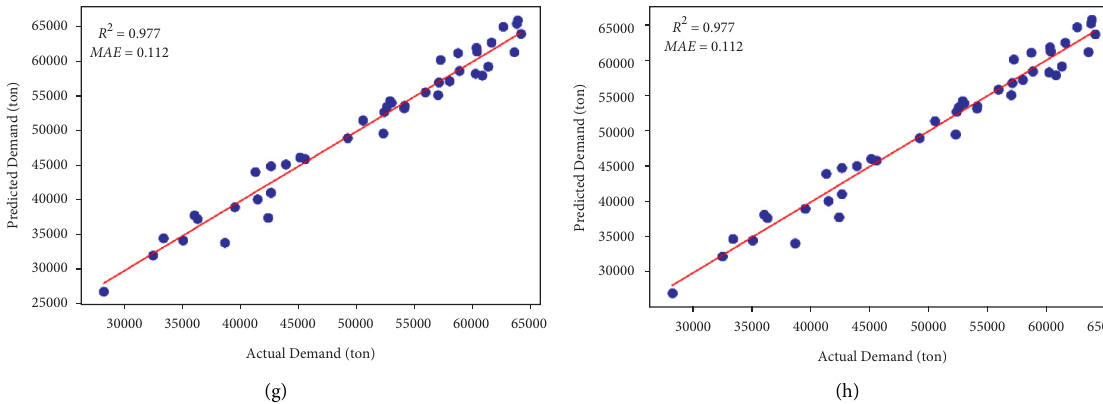
Figure 5: Correlation-based comparison between predicted demand and actual demand during the testing phase (a) SVR, (b) ELM, (c) MLP, (d) RFR, (e) GBR, (f) XGBR, (g) STACK 2 , and (h) STACK